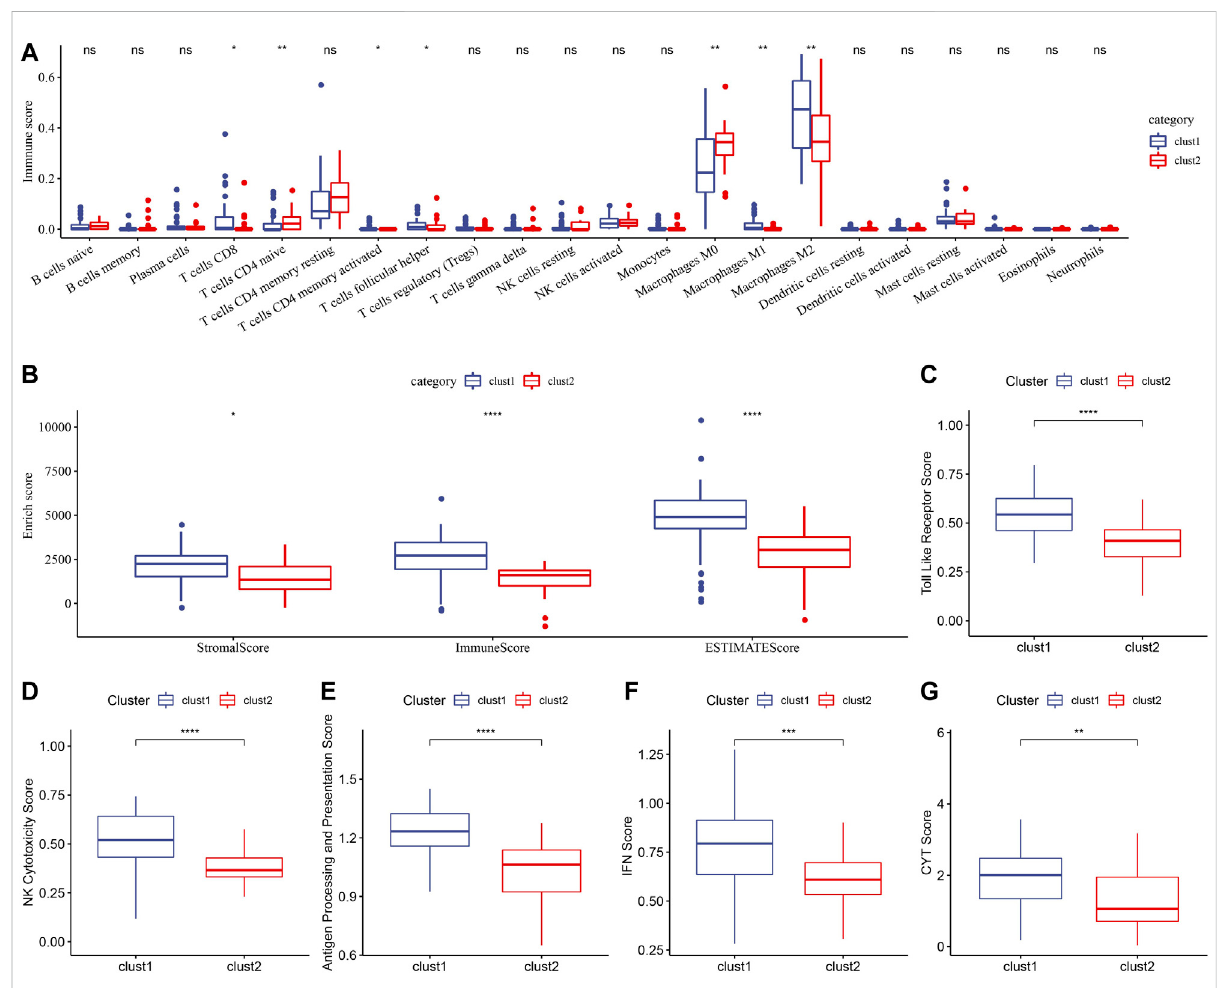
FIGURE 4 Immune cell in fi ltration and TME-related scores of two metabolic subtypes. (A) : CIBERSORT determined the relative in fi ltration levels of 22 immune cells between the two metabolic subtypes in Target. (B) : ESTIMATE analyzed stromal score and immune score and ESTIMATE score of twometabolicsubtypes. (C) :Toll-likereceptorscorecomparisonbetweenCluster1andcluster2. (D) :NKcytotoxicityscoredifferencesbetweenthe twometabolicsubtypesinTarget. (E) :Thescoreofantigenprocessingandpresentationincluster1andcluster2. (F,G) :ThedifferenceofIFN- γ score and CYT score between the two metabolic subtypes. For this fi gure, the asterisks idicated the statistical p value, * p < 0.05, ** p < 0.01, *** p < 0.001, **** p <